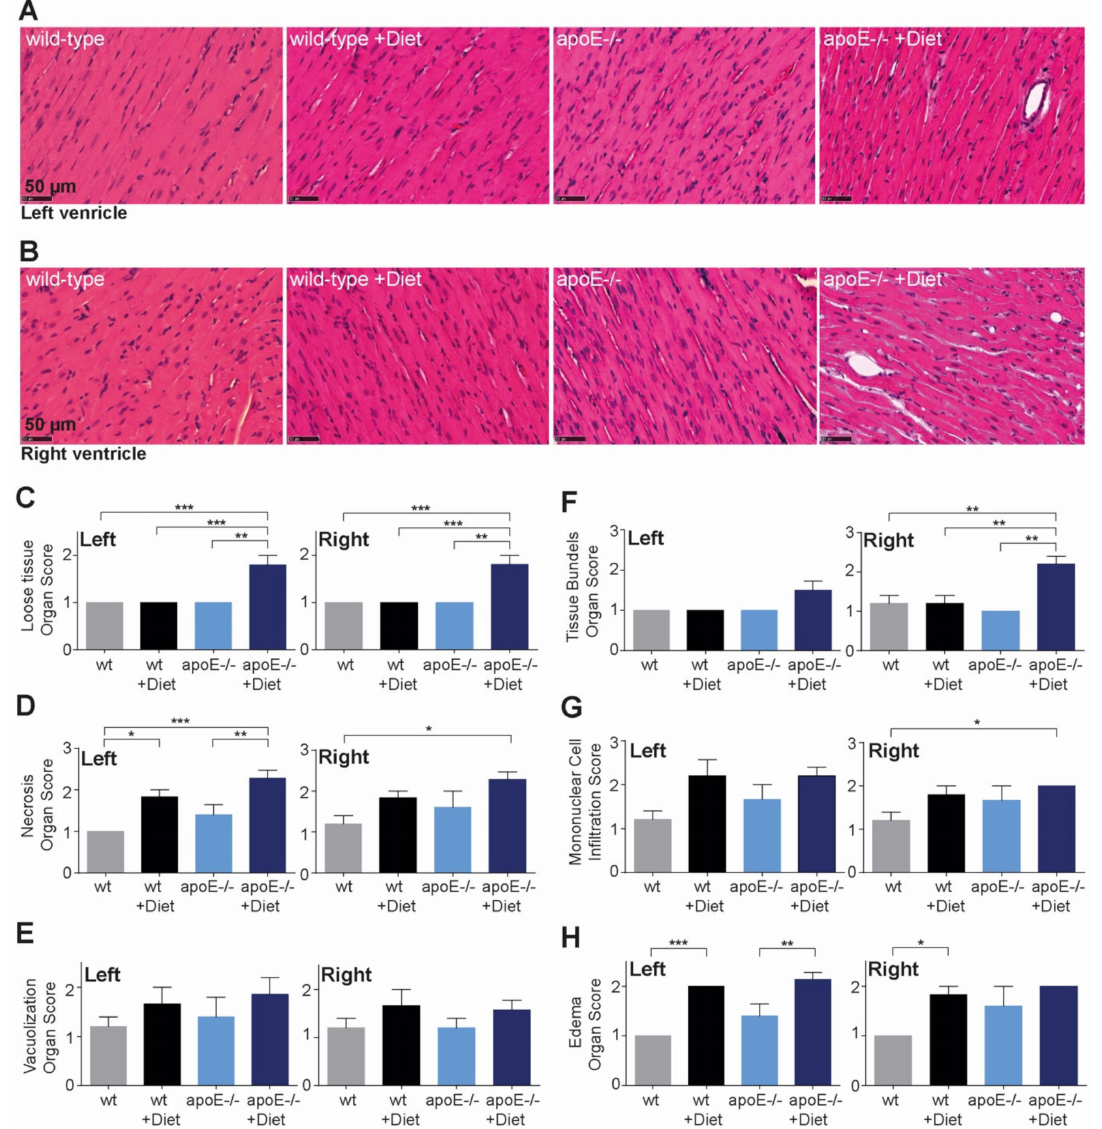
Figure 3. Changes in heart morphology of apoE − / − rats after feeding high-fat diet Twelve weeks (age 20 weeks) after feeding normal or high-fat diet, apoE − / − rats showed differentiated pathological changes in left and right ventricle compared with wild-type rats ( A – H ). While interstitial tissue of each ventricle was equally affected and presented necrosis foci, the right ventricle showed more thin tissue bundles and mononuclear cell infiltration and the left ventricle, more edema in apoE − / − rats fed with high-fat diet. * p < 0.5, ** p < 0.01, *** p < 0.001, n = 5–15, scale bar is indicated in the first image of each